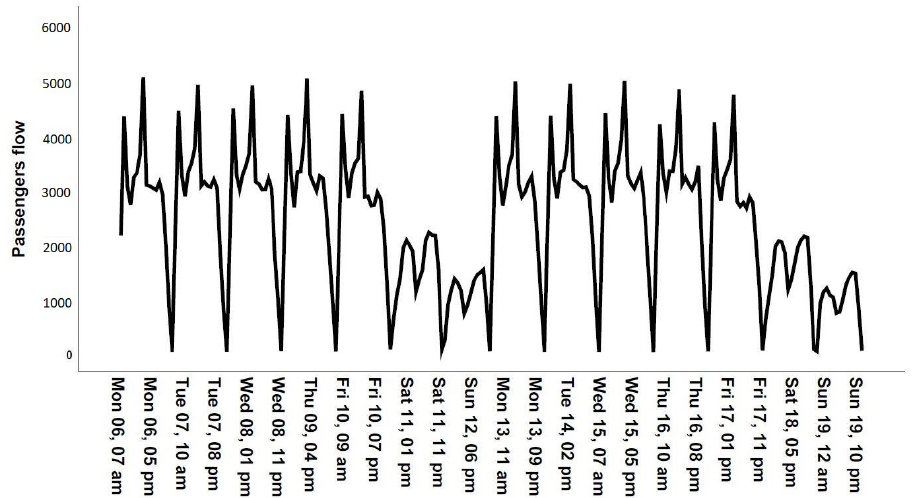
Figure 1. Series for the 14 days, 17 h by